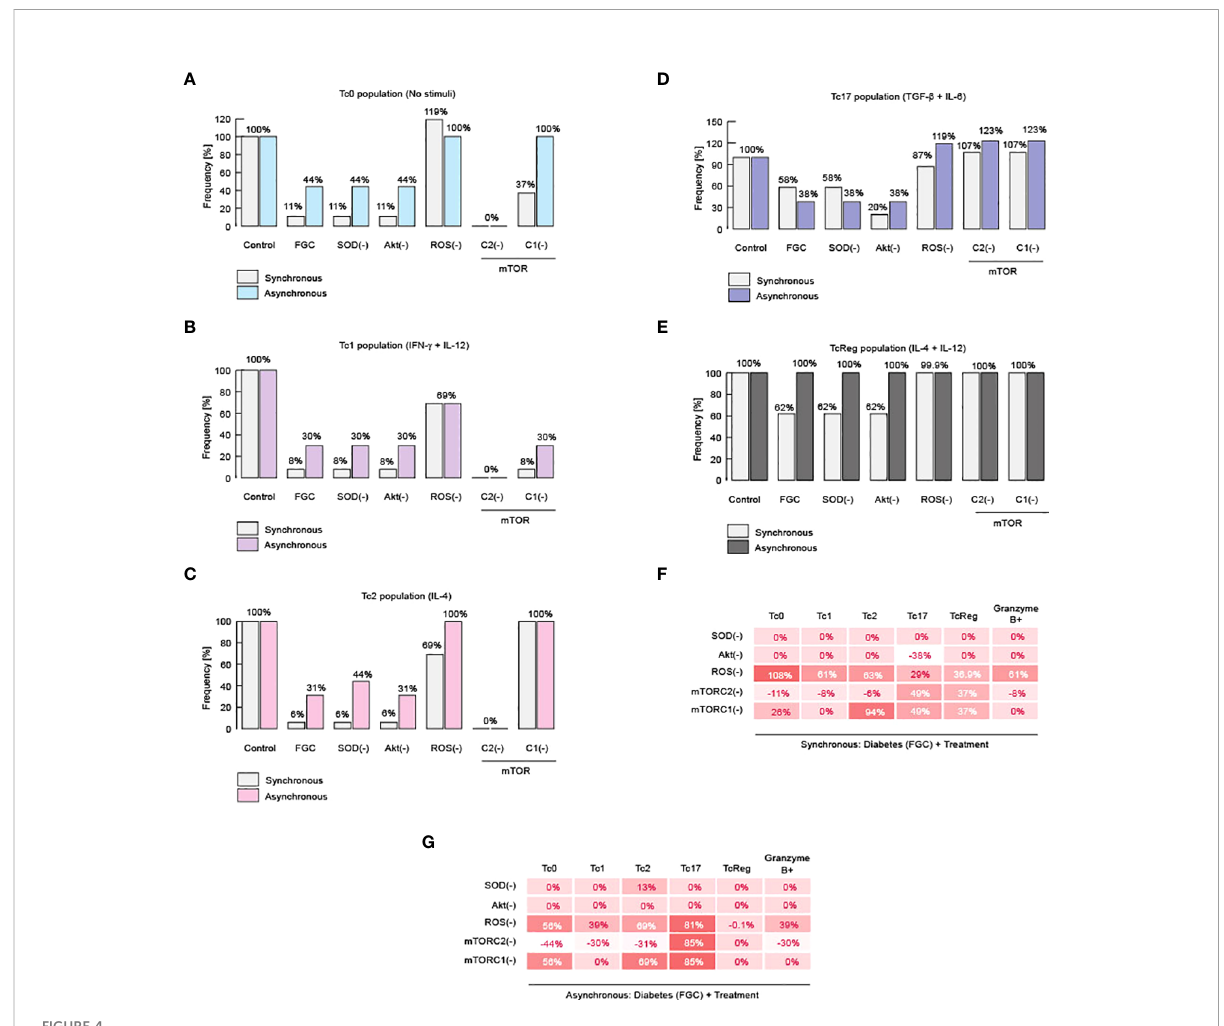
FIGURE 4 Impairment of CD8+ T cell differentiation is caused by ROS. Results of knockout simulation analysis. (A) Effects of knockouts over Tc0 phenotype. (B) Effects of knockouts over Tc1 phenotype. (C) Effects of knockouts over Tc2 phenotype. (D) Effects of knockouts over Tc17 phenotype. (E) Effects of knockouts over TcReg phenotype. (F) Summary of total changes due to knockouts according to the synchronous model. (G) Summary of total changes due to knockouts according to the asynchronous